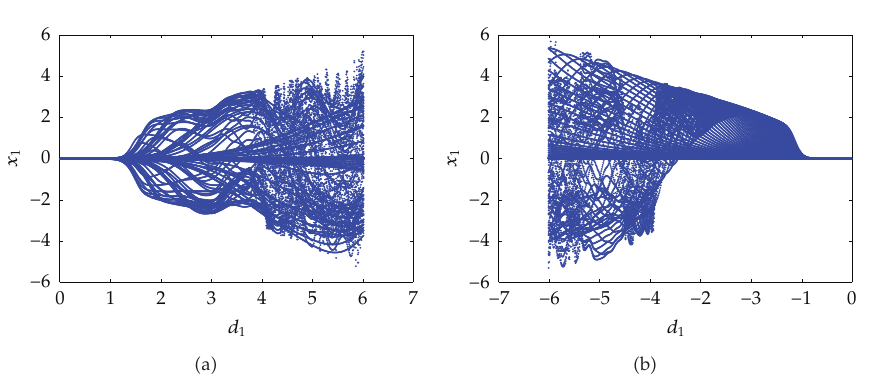
Figure 4: (cid:4) a (cid:6) Phase plot in space (cid:4) x 1 ,x 2 (cid:6) for system (cid:4) 4.1 (cid:6) with initial condition (cid:4) 0.6,0.6 (cid:6) and d 1 (cid:7) 0 . 79. (cid:4) b (cid:6) Phase plot in space (cid:4) x